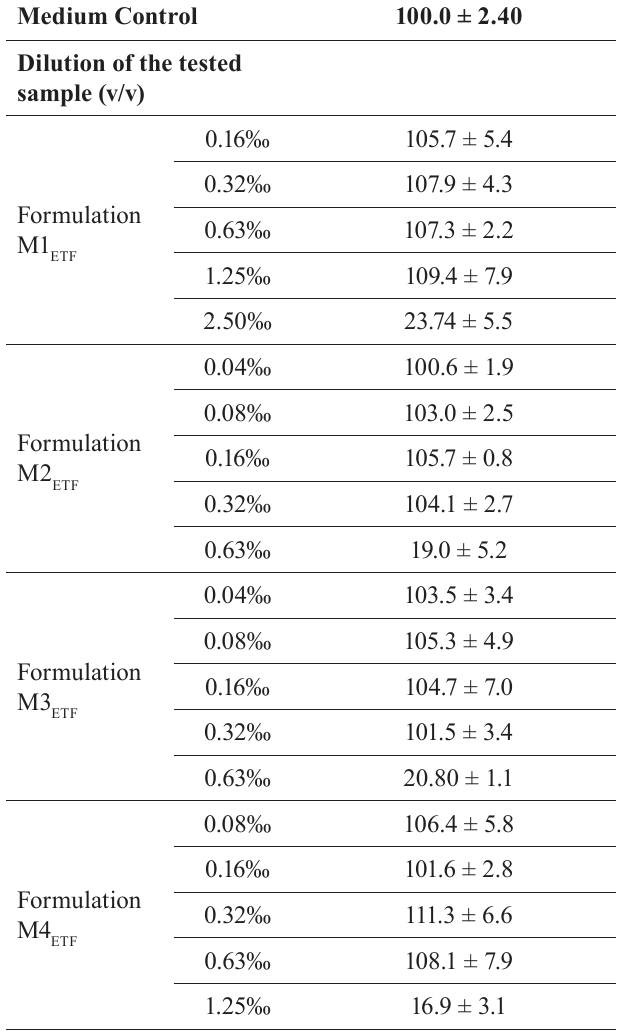
TABLE V - E ffects of formulations (M1 and M4 ) on the viability of LPS-treated RAW 264.7 ETF